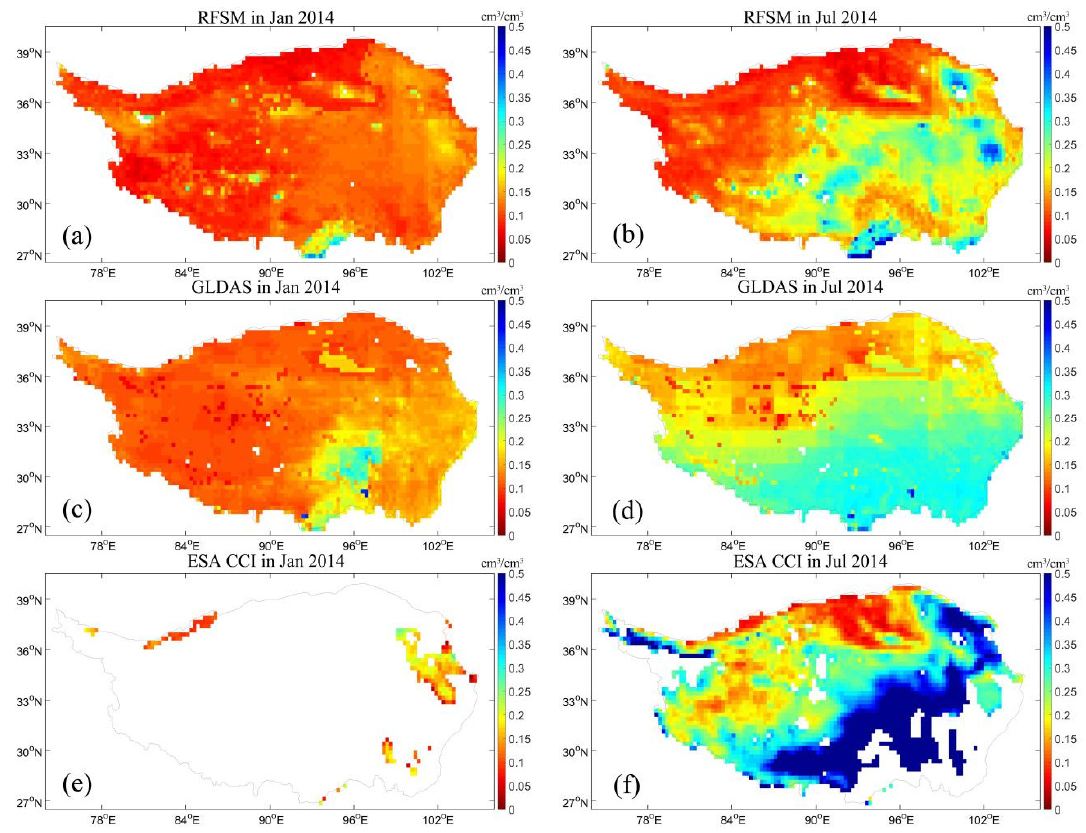
Figure 12. Spatial distribution of RFSM, GLDAS and ESA CCI SM in 2014: ( a ) RFSM in Jan; ( b ) RFSM in Jul; ( c ) GLDAS in Jan; ( d ) GLDAS in Jul; ( e ) ESA CCI in Jan; ( f ) ESA CCI in